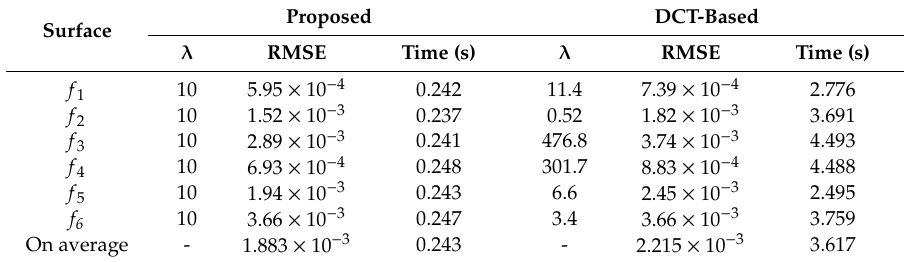
Table 1. Results of the proposed and DCT-based methods for interpolating the six surfaces. Surface